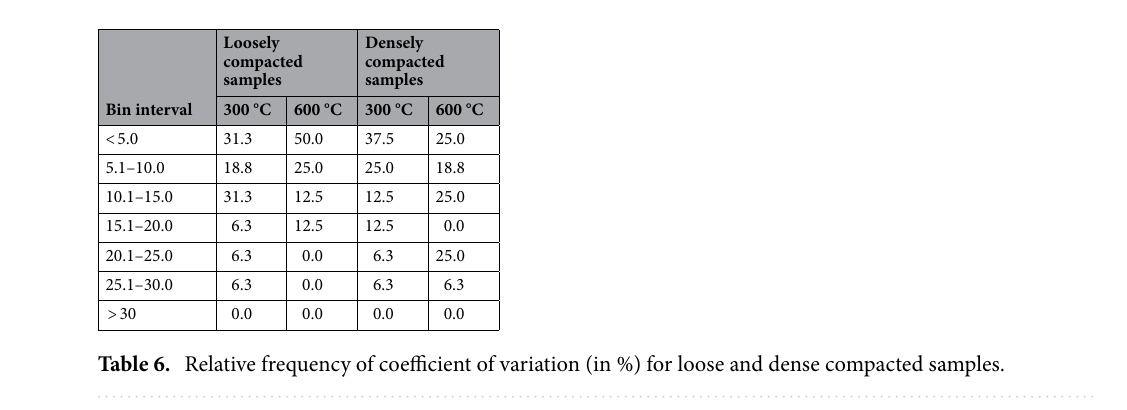
Figure 9. Moisture content of ( a , b ) loose and ( c , d ) dense samples various with suction.